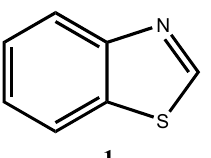
Figure 1. Structural formulas of benzo[ d ]thiazol.